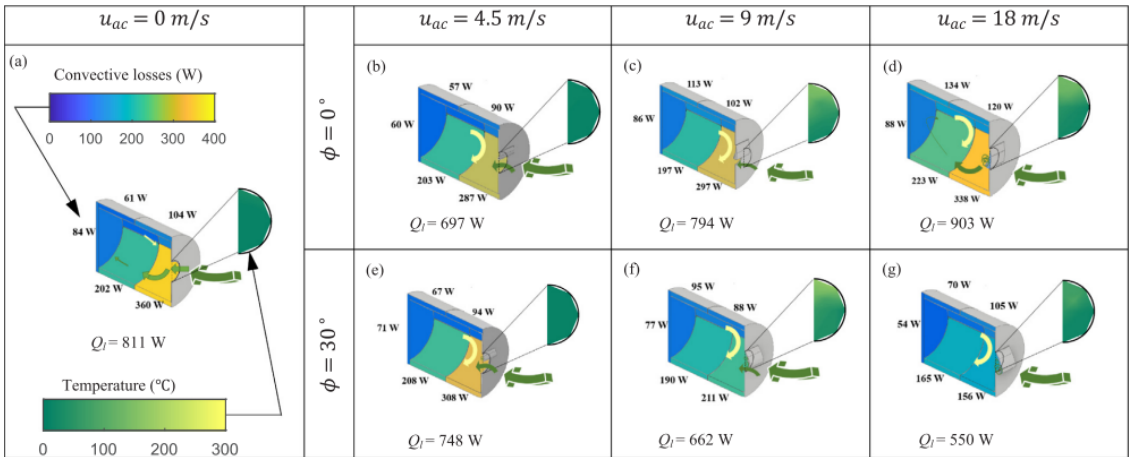
Figure 14. Color maps of the surface distribution over the temperature of the air and measured convective heat losses in the aperture plane for a series of conditions. ( a ) uac = 0 m/s; ( b ) uac = 4.5 m/s, ϕ = 0°; ( c ) uac = 9 m/s, ϕ = 0°; ( d ) uac = 18 m/s, ϕ = 0°; ( e ) uac = 4.5 m/s, ϕ = 30°; ( f ) uac = 9 m/s, ϕ = 30°; ( g ) uac = 18 m/s, ϕ = 30°. Reprint ed with permission from Ref. [31]. 2020, Elsevier.